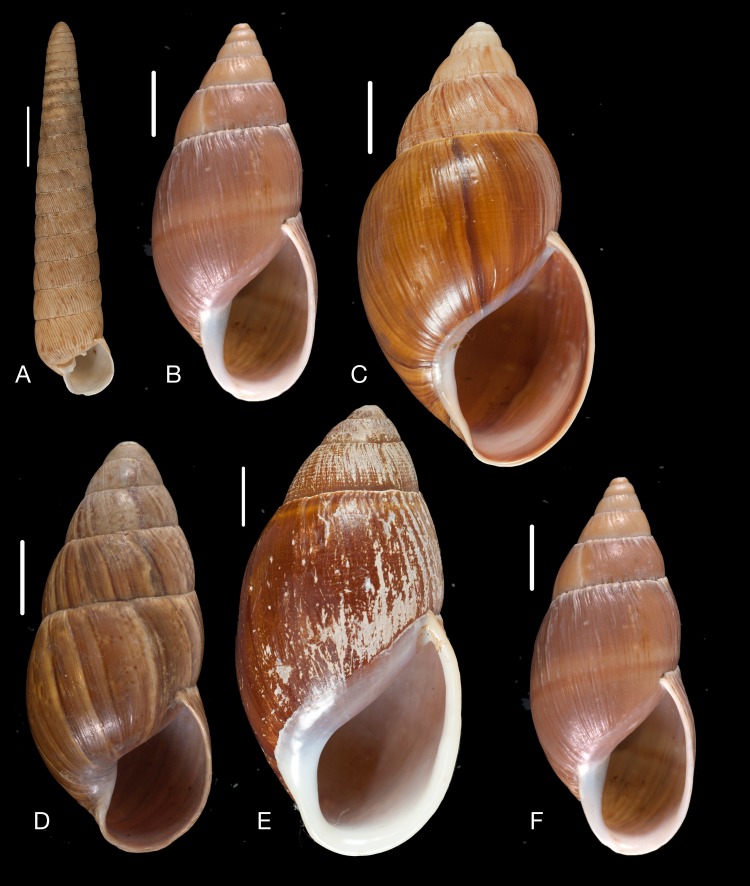
Material collected by the CCP.(A–F) Megaspiridae. Megaspira elatior (Spix in Wagner, 1827), MNCN 15.05/19283, (A) ventral view; Thaumastus (Thaumastiella) cf. koepckei
Zilch, 1953, MNCN 15.05/13501, (B) ventral view; Thaumastus (Thaumastus) achilles (Pfeiffer, 1853), MNCN 15.05/13299, (C) ventral view; Thaumastus (Thaumastus) cf. orcesi
Weyrauch, 1967, MNCN 15.05/7567, (D) ventral view; Thaumastus (Thaumastus) foveolatus (Reeve, 1849), MNCN 15.05/13497, (E) ventral view; Thaumastus (Thaumastus) hartwegi (Pfeiffer in Philippi, 1846), MNCN 15.05/13507, (F) ventral view. Scale line 1 cm.